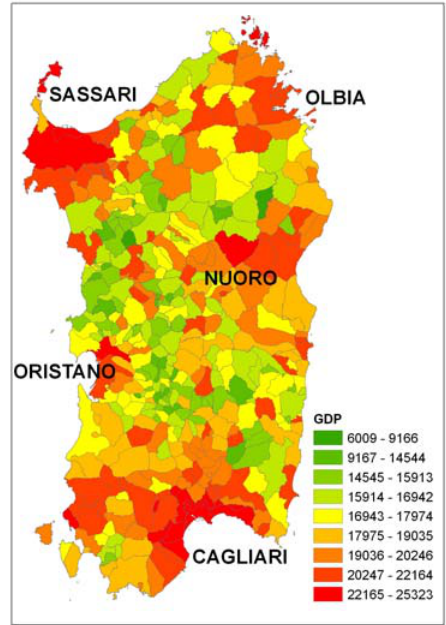
Figure 3. Spatial distribution of municipal average household income (AHI).